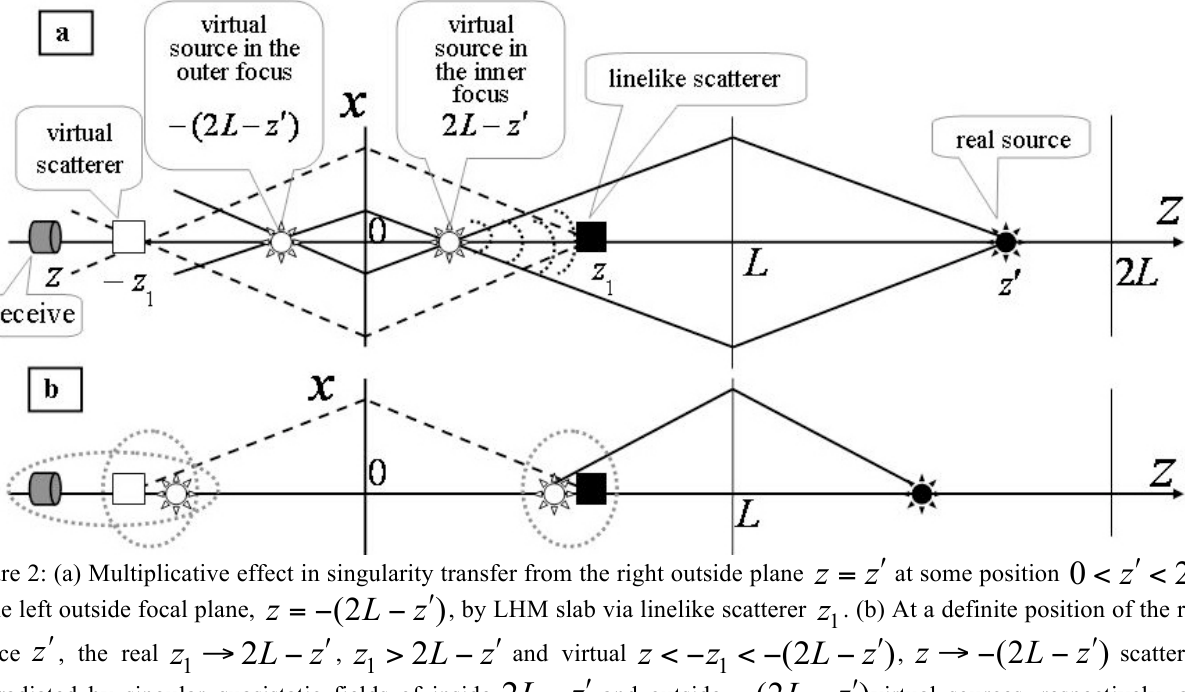
z . (b) At a definite position of the real 1